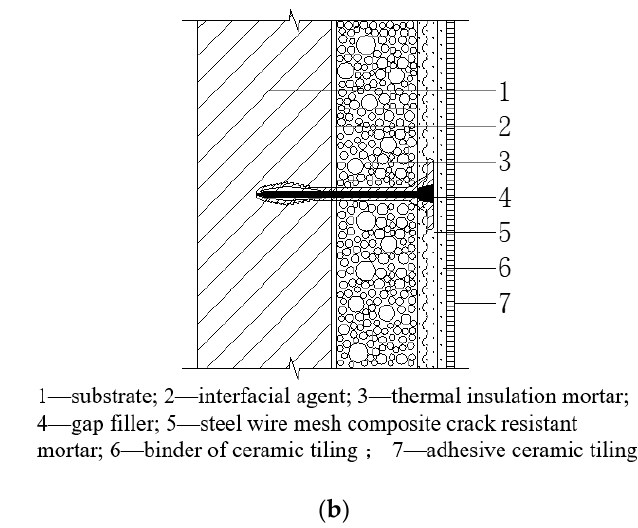
Figure 2. Details of thermal insulation mortar ETICS. ( a ) Thermal insulation mortar ETICS with plastic paint finish. ( b ) Thermal insulation mortar ETICS with adhesive ceramic tiling.